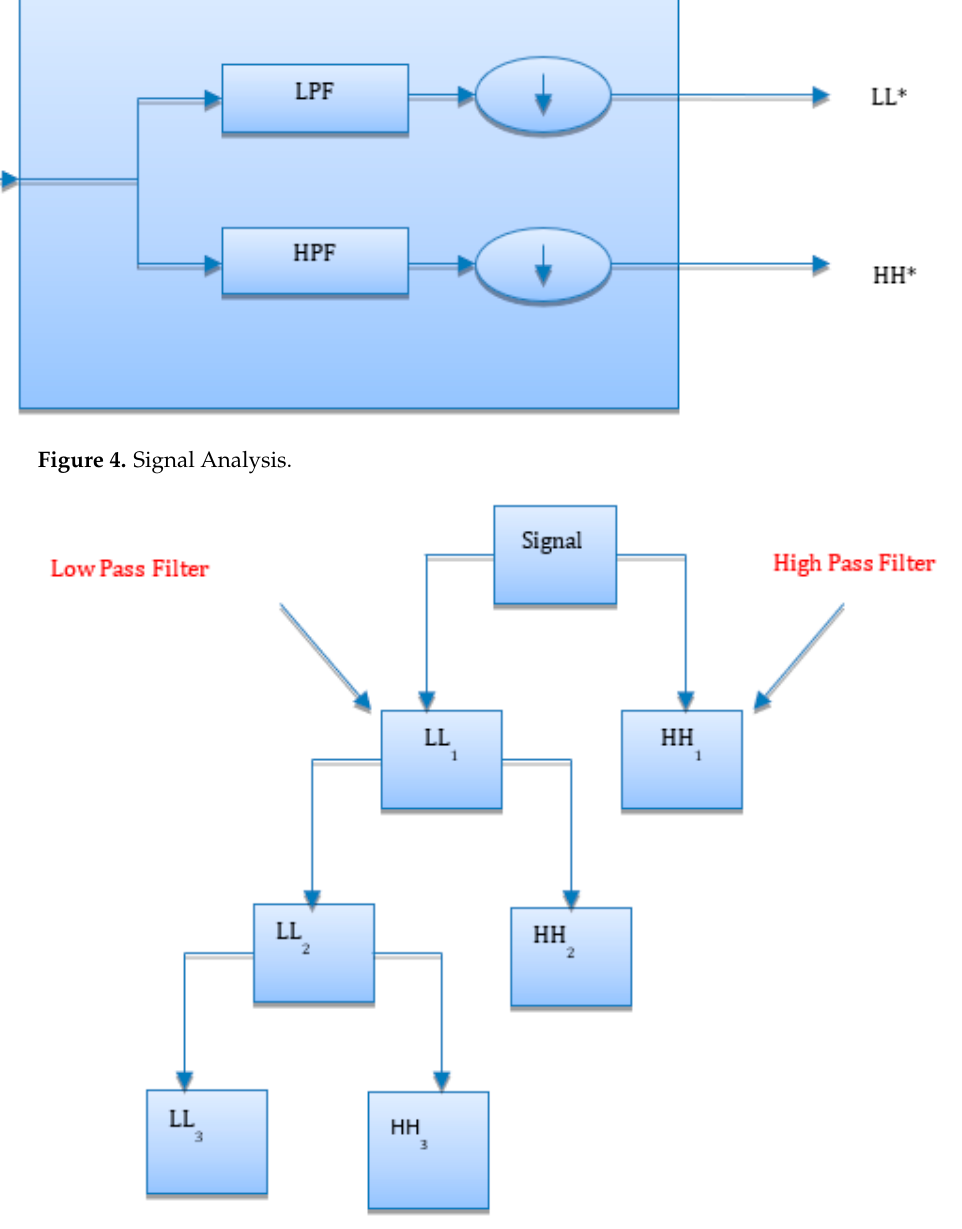
Figure 5. Wavelet Figure 5. Wavelet Decomposition.